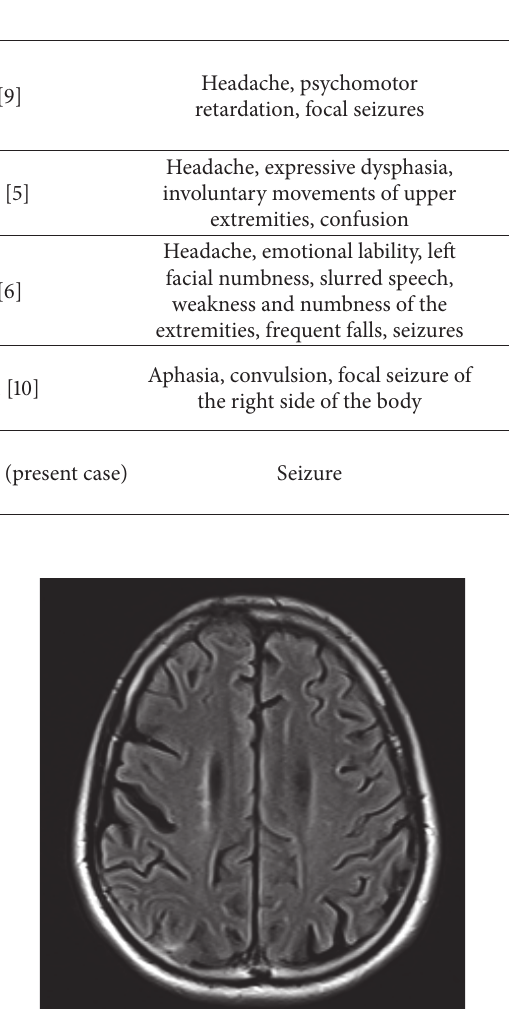
Figure 4: Brain MRI finding 2 years after treatment. T2 FLAIR image (1.5T; TR 10000 ms, TE 108ms). MRI performed 2 years after treatment no longer shows linear hyperintensity of the lep-